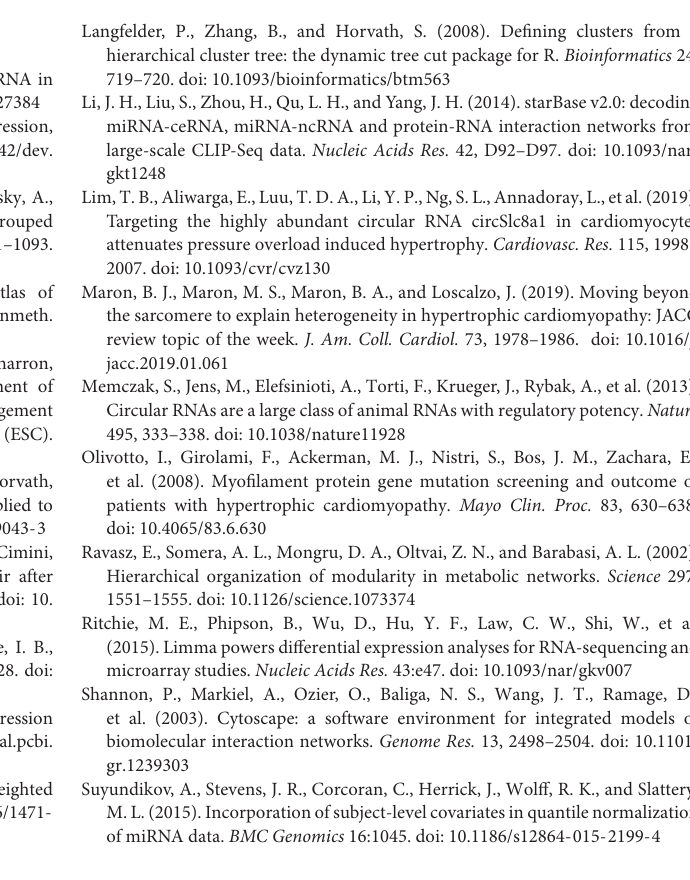
FIGURE S5 | Differential expression analysis of the circulating transcriptome by Limma. (A) Volcano plot for circRNAs. (B) Heatmap for differentially expressed circRNAs. (C) Volcano plot for mRNAs. (D) Heatmap for differentially expressed mRNAs. Each point in volcano plot corresponded to one RNA. Red points indicated upregulated RNAs and blue points indicated downregulated RNAs. A total of 391 upregulated circRNAs, 384 downregulated circRNAs, 229 upregulated mRNAs, and 140 downregulated mRNAs were identified by the Limma method. Both differentially expressed circRNAs and mRNAs can distinguish HCM patients and healthy controls. In this Limma analysis, the p-value was adjusted by the Benjamini–Hochberg method. HCM, hypertrophic cardiomyopathy; Limma, linear models for microarray data. TABLE S1 | Original intensity values of each RNA in each sample. TABLE S2 | Normalized intensity values of each RNA in each sample. TABLE S3 | Clinical characteristics of HCM group and control group. TABLE S4 | Hub differential expressed circRNAs in magenta module. TABLE S5 | Hub differential expressed circRNAs in red module. TABLE S6 | GO and KEGG terms for each circRNA in ceRNA